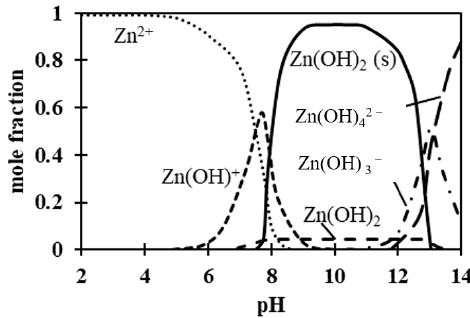
Figure A5. Dependences of Zn(II) forms on the pH value of the aqueous solutions (c 0 = 0.15 mmol dm − 3 ).